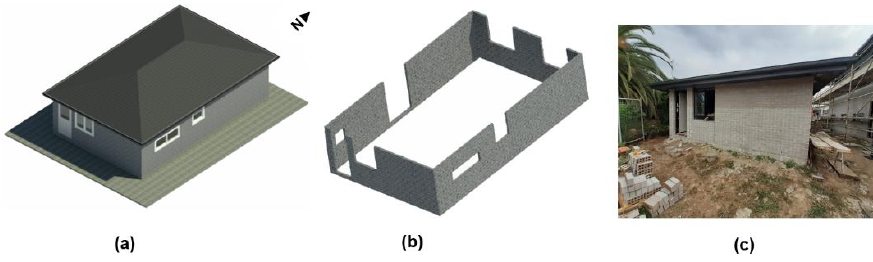
Figure 2. As-design and actual models: ( a ) as-designed BIM model; ( b ) as-designed walls only; ( c ) actual model under construction in which scaffolding, roof and other objects are accepted as noise.